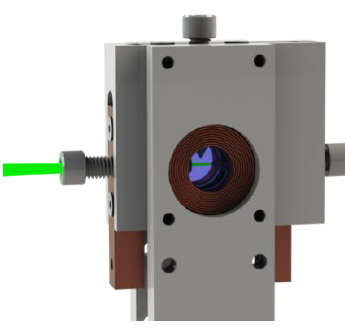
Figure 8. Time of current handoffs for different voltages and shunt spacings. 4. Discussion We have demonstrated a new type of plasma opening switch, capable of switching on and off kiloamp currents at kilovolt potentials on microsecond timescales. We envisaged two parallel routes forward. First, our immediate interest in this device is it could be used as a way to reduce the thermal load on a small, high-repetition-rate, dense plasma focus (DPF) [10]. By redirecting the flow of current